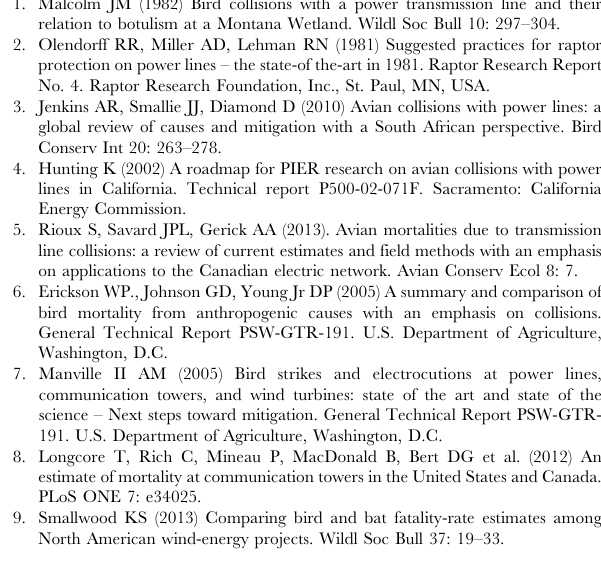
Table S1 Studies reviewed but excluded from analyses. (DOCX) Table S2 Raw counts of bird species found in studies of power line collision. Text S1 Supplementary Methods. Detailed description of methods used to define probability distributions in mortality estimation